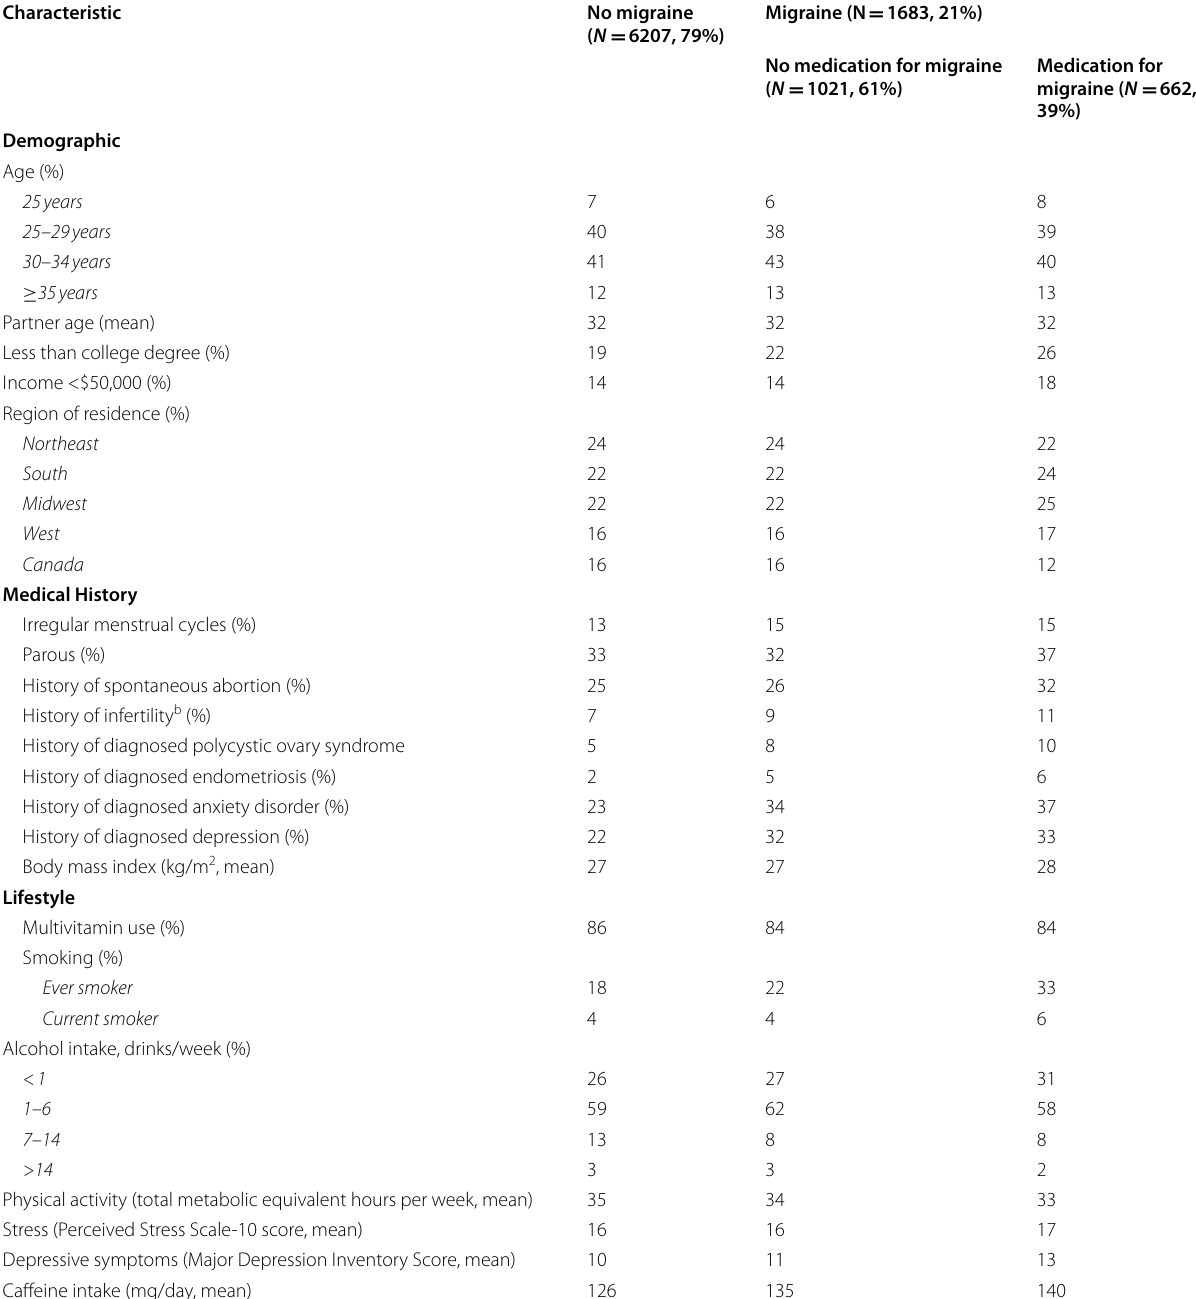
a Migraine defined as any participant report of a history of migraine at baseline or migraine medication use at baseline or during follow-up. b History of infertility defined as a participant report of a previous pregnancy attempt over > 12